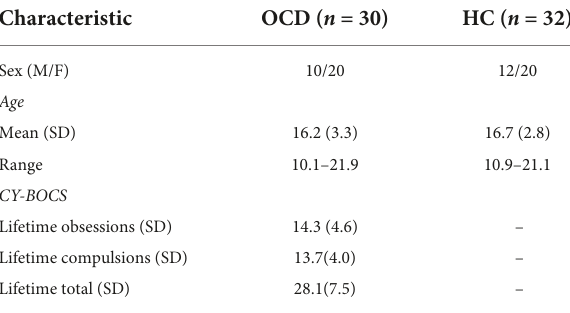
TABLE 1 Demographic and clinical